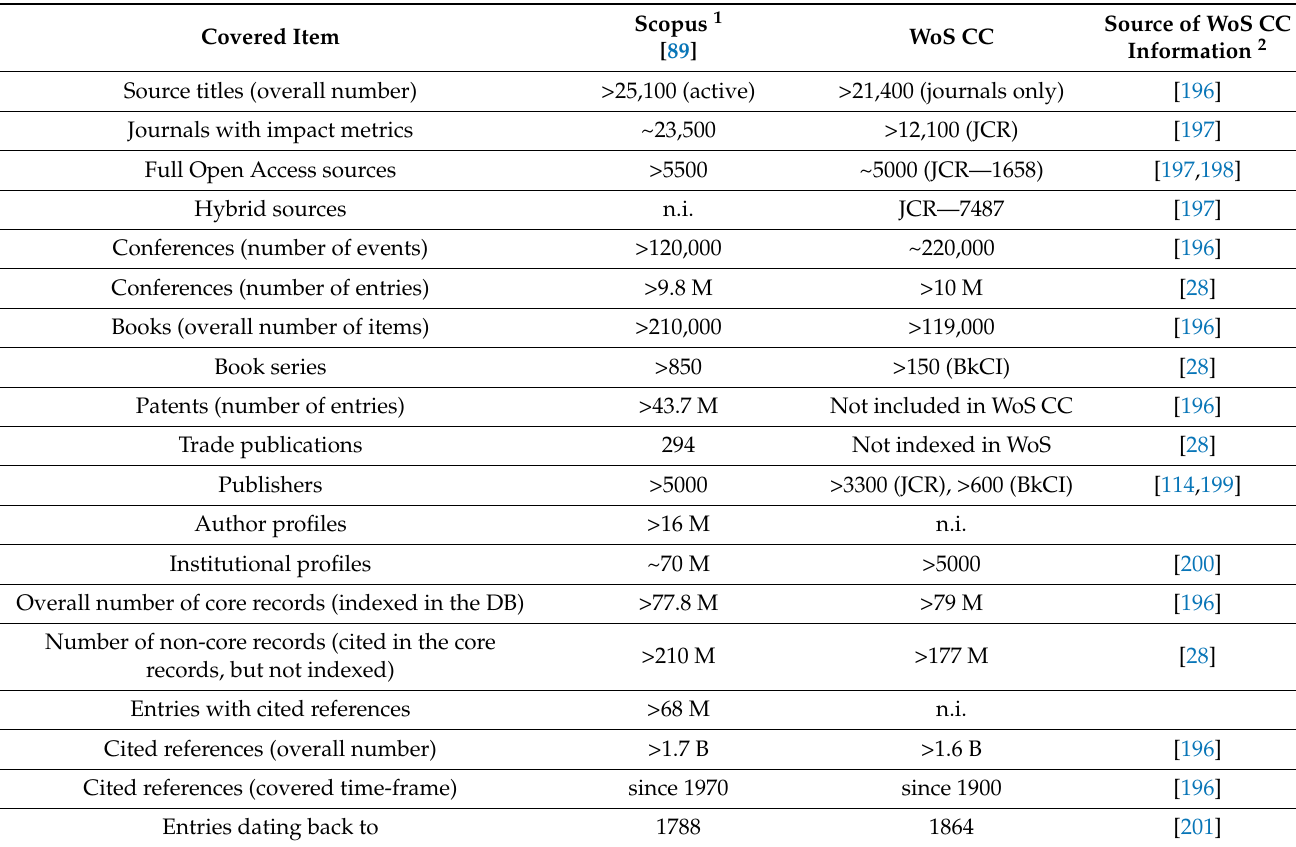
Table 1. Numbers describing content coverage and other information provided in Scopus and Web of Science Core Collection (WoS CC) (n.i.—not indicated by the